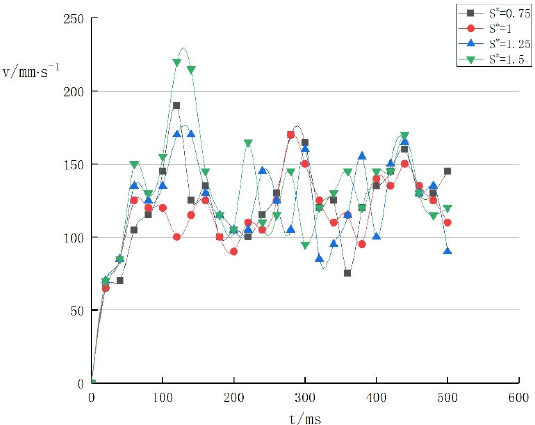
Figure 8. Graphs of the average rising velocity of bubbles under different S*. Table 2. Numerical table of rising swing amplitude of bubbles with different diameters.